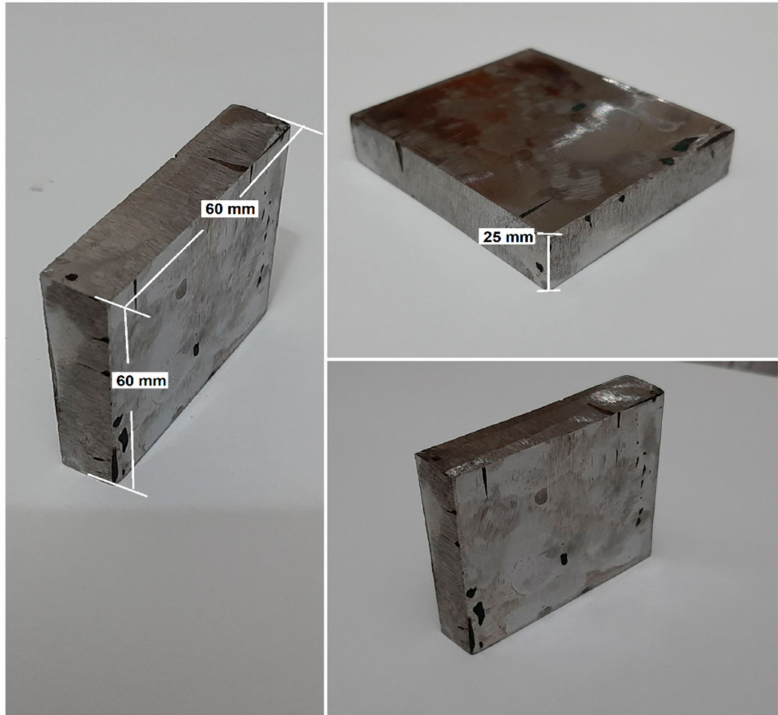
Figure 4. Sample of AISI 1018 steel blocks.